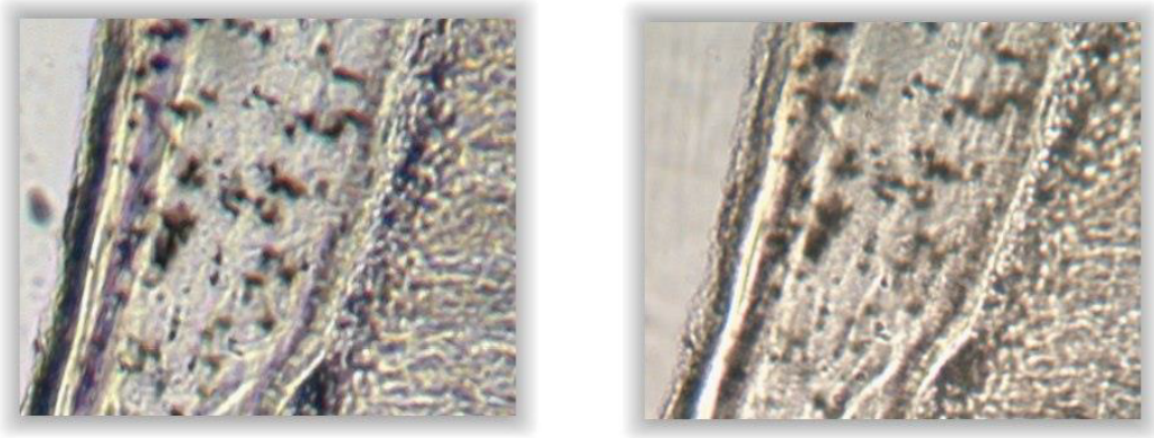
Figure 10. Another example of magnification comparison, × 40 on the left, × 100 on the right, showing no significant